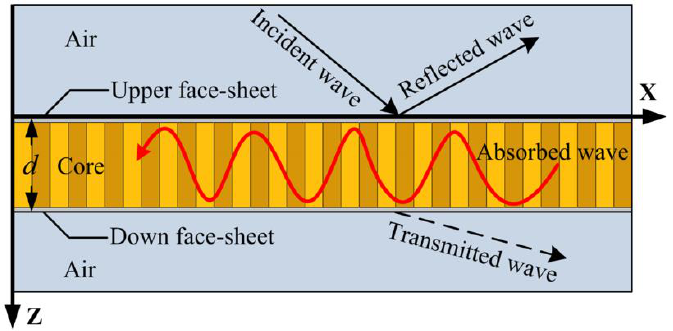
Figure 1. The transmission, reflection, and absorption of waves at an infinite sandwich structure.